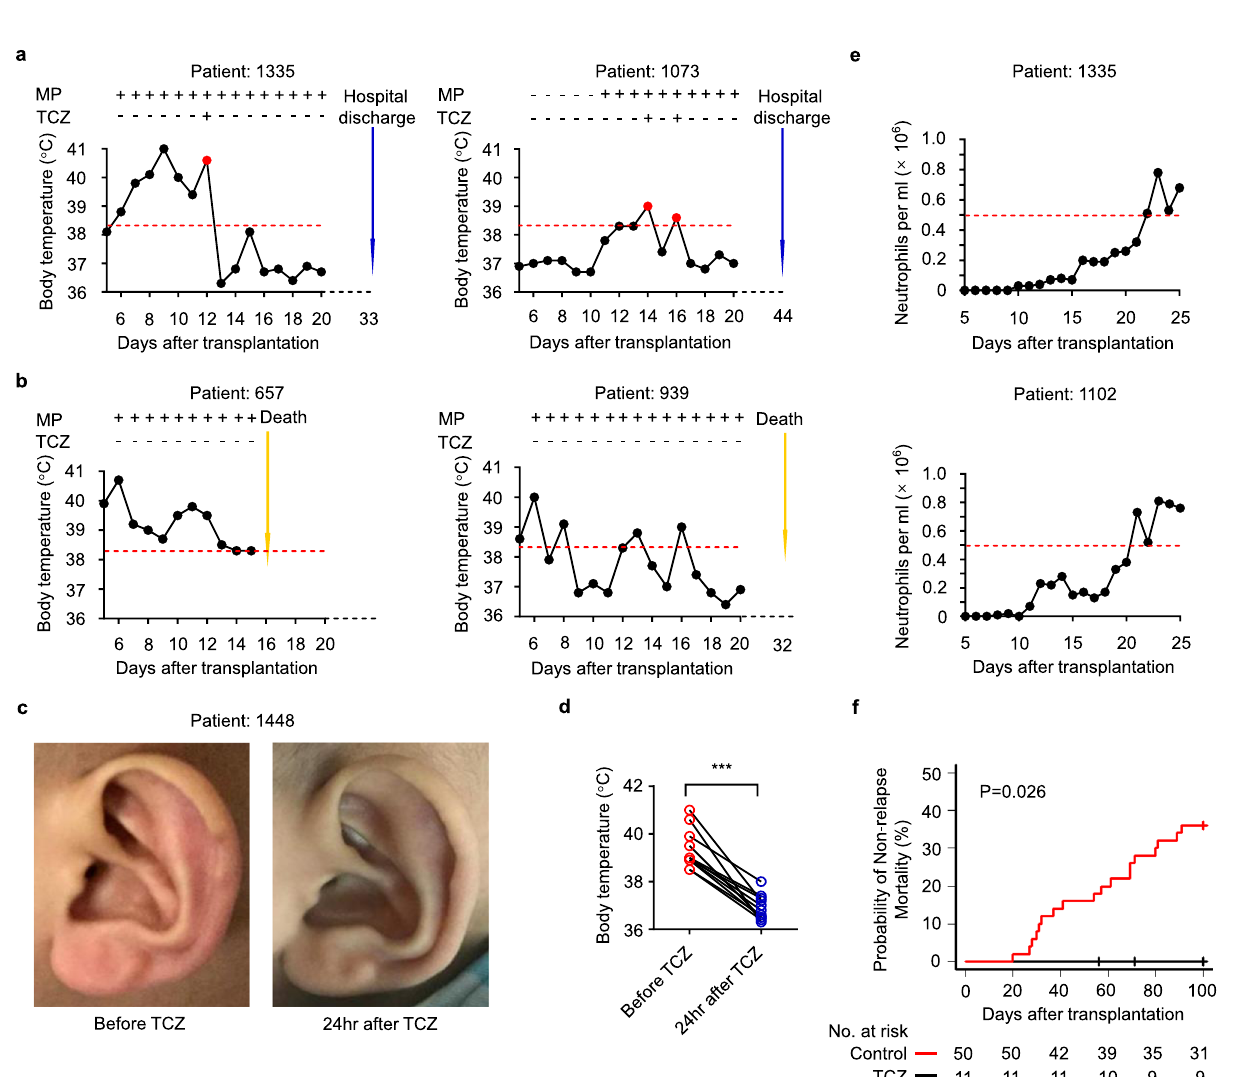
Fig. 4 IL-6 production in patients with PES. a Frequency of IL-6-producing CD14 + monocytes within the CD45 + population from peripheral blood stem cells or cord blood mononuclear cells during a 6-h culture period. Representative plots are shown from a total of nine independent experiments. b , c ELISA of IL-6 in supernatants from PBSC or CB during a 6-h culture period. PBSC, n = 9, CB, n = 11. Paired t test (two-sided). d Dynamic changes in the plasma cytokine levels of patients with PES or without PES (PES, n = 6; Non-PES, n = 4). e Plasma cytokine levels in patients with or without PES. PES, n = 10; Non- PES, n = 9. Mann – Whitney test (two-sided). f Linear regression analysis of the association between the concentration of GM-CSF and IL-6 ( p = 2.121e-9, R = 0.738, by using a two-sided Pearson correlation coef fi cient). g Frequencies of IL-6-producing monocytes, T cells, and NK cells within the CD45 + populations from peripheral blood in patients with PES or healthy donors, n = 3. In order to compare means (PES vs. Non-PES), Mann-Whitney test (two- sided) was used in ( d ). Data are shown as means ± standard error of the mean (SEM). n.s., not signi fi cant, ** p < 0.01. Source data are provided as a Source Data fi le.